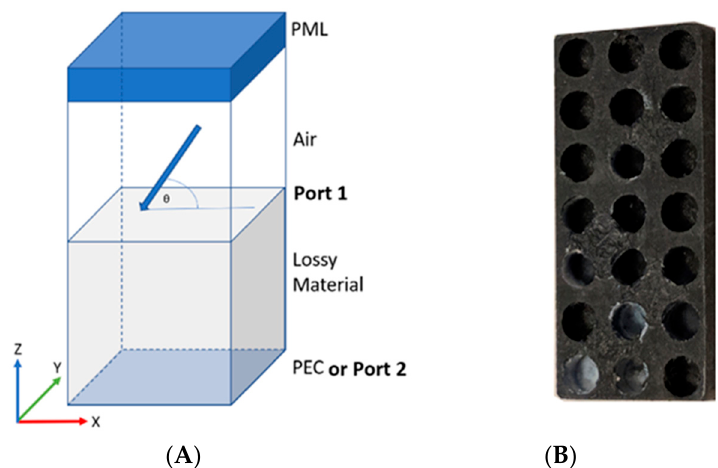
Figure 2. ( A ) Schematic of unit cell used in COMSOL simulations. The top of the cell is truncated with a perfectly matched layer (PML) to prevent reflections at the top boundary. EM waves with incident angle θ are generated from Port 1 and are incident upon a lossy material with predefined permittivity and permeability. The bottom of the cell is either backed by a perfect electrical conductor or a second port. The unit cell is periodic in the x / y direction and finite in the z direction. ( B ) A representative xGNP / PLA sample after being machined. The periodic porous array is milled on two separate halves which are then bonded together to form completely encapsulated pores.